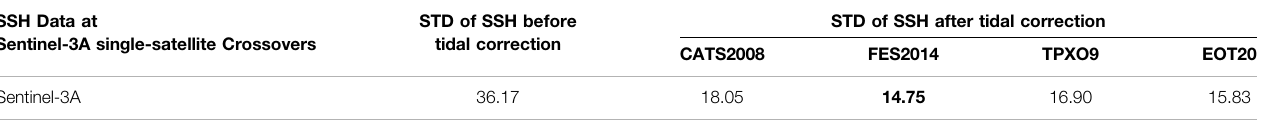
TABLE 4 | STD of the SSH residuals at dual satellite crossovers before and after tidal correction. Bold values denote the smallest STD value (Unit: cm). SSH Data at Sentinel-3A single-satellite